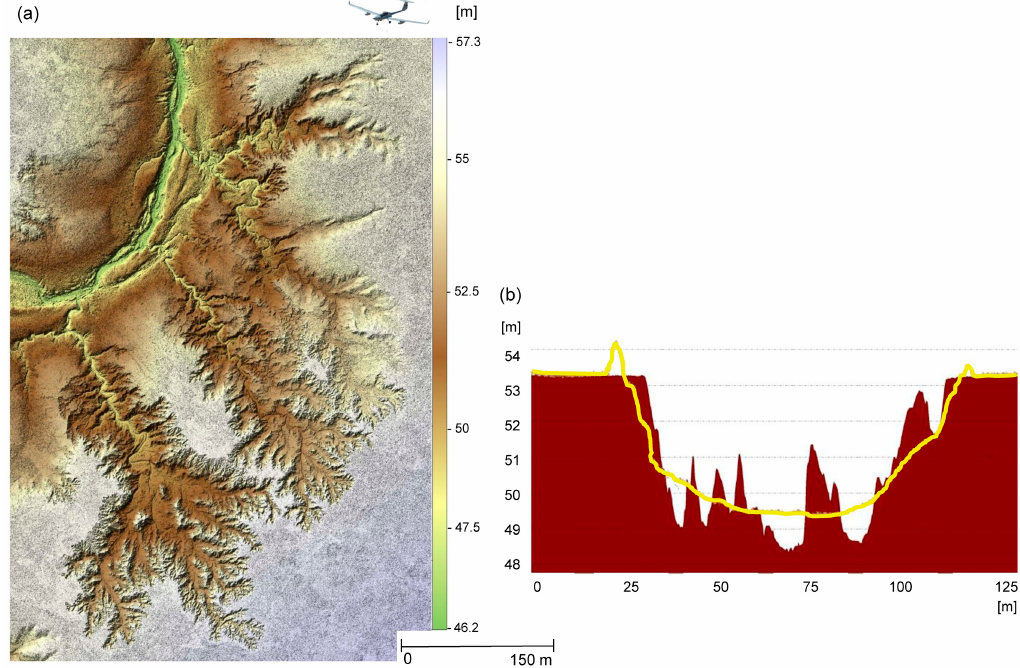
Figure6. ErosiongulliesinNorthernQueensland(Australia)represented( a )bya10cm-DigitalElevation Figure 6. Erosion gullies in Northern Queensland (Australia) represented ( a ) by a 10 cm-Digital Model(DEM)derivedfrommultipleoverpasseswiththeRIEGLQ680i-SLiDARand( b )bycross-sections Elevation Model (DEM) derived from multiple overpasses with the RIEGL Q680i-S LiDAR and ( b ) by depicted as solid area and line before and after remediation earthworks, cross-sections depicted as solid area and line before and after remediation earthworks, respectively.